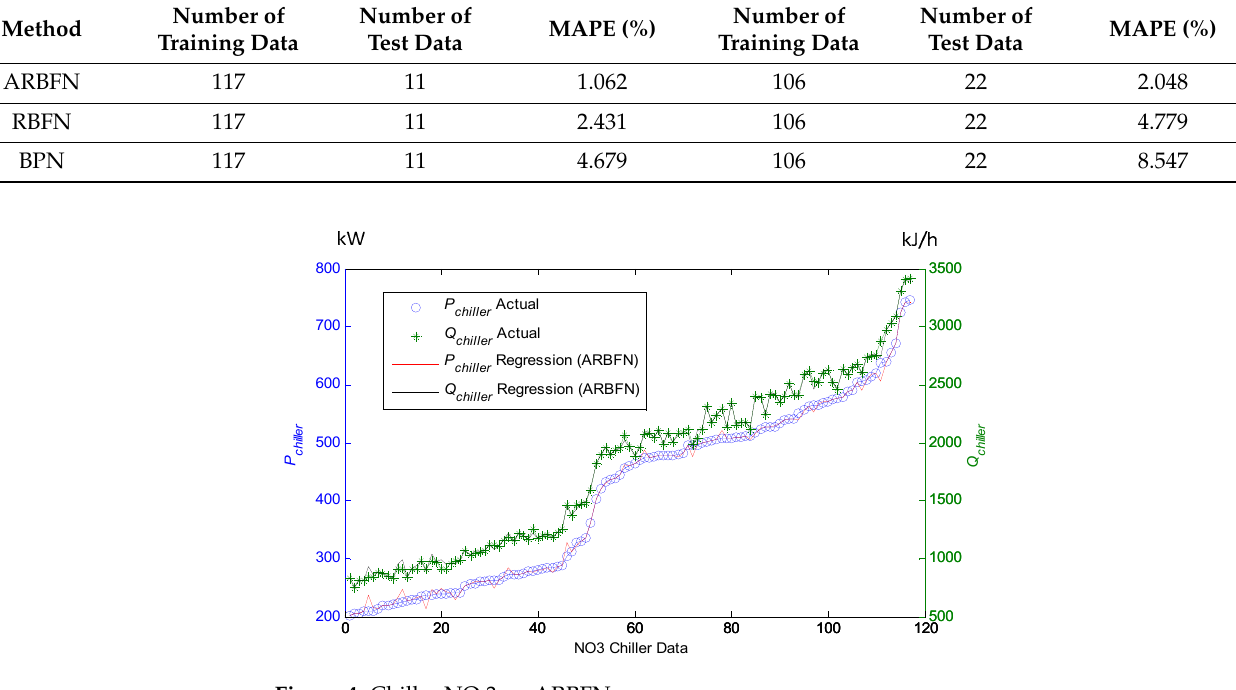
Figure 4. Chiller NO.3 on ARBFN. Table 2. Performance comparison with various control methods in the NO.3 chiller net.